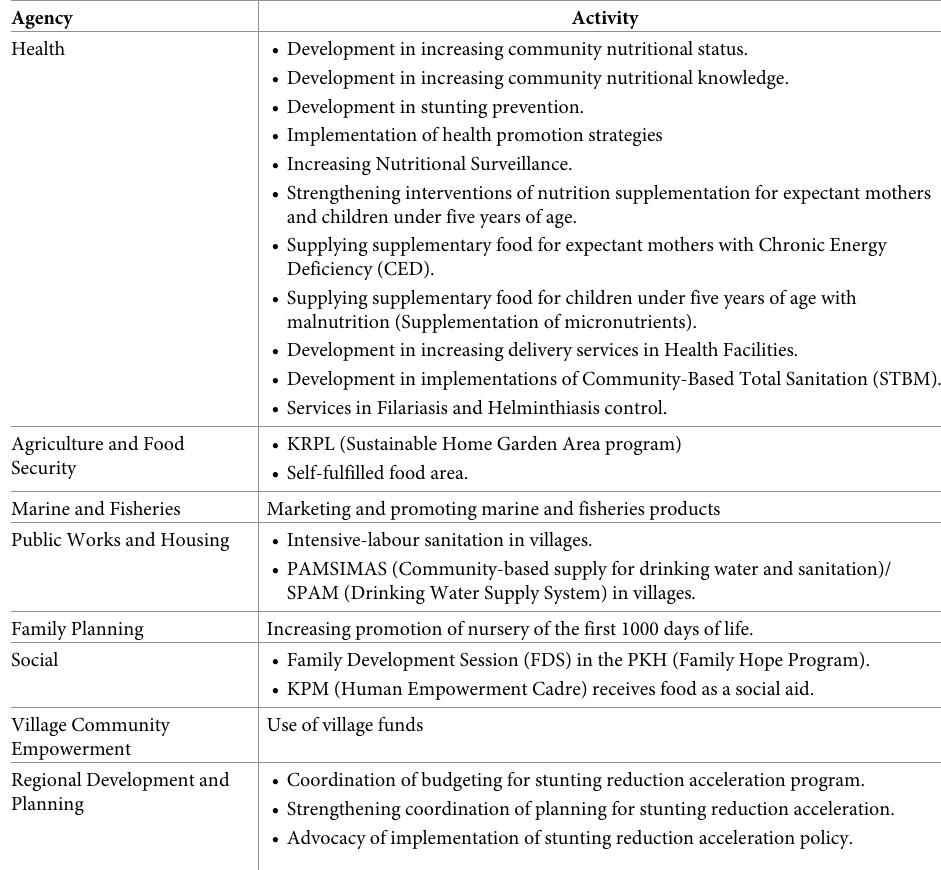
Table 2. Programs related to stunting by the district government and its various